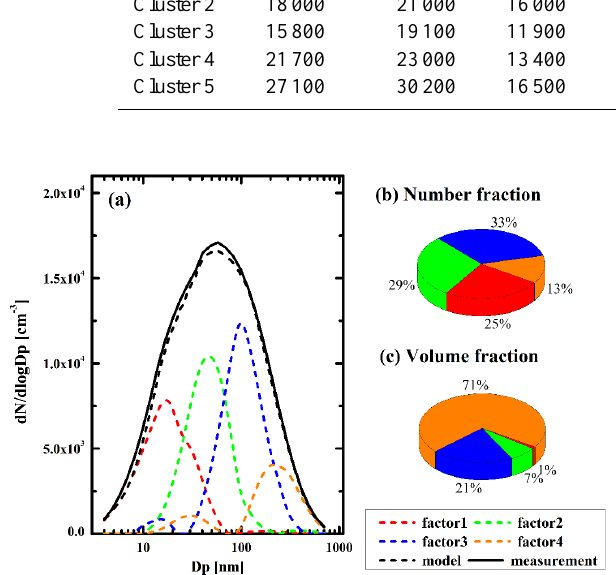
Fig. 6. (a) Number size distribution profiles of four factors. The Figure 6: (a) Number size distribution profiles of four factors. The black dashed and solid lines present the 772 black dashed and solid lines present the modeled and observed par- modelled and observed particle number size distributions, respectively; (b) and (c) are the fractions of four factors 773 ticle number size distributions, respectively; (b) and (c) are the frac- in particle number and volume concentrations. 774 tions of four factors in particle number and volume concentrations.